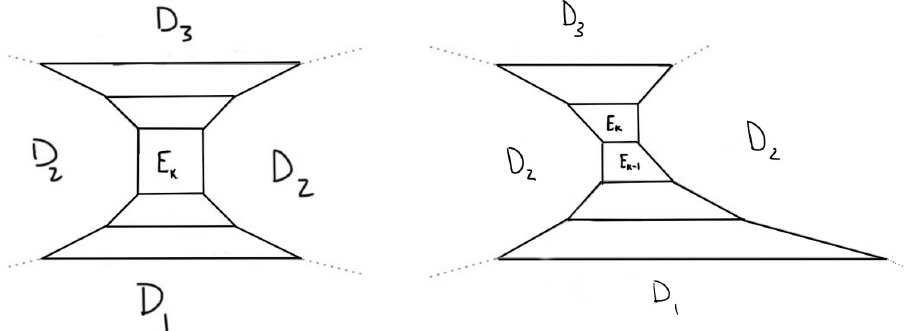
Figure 6. The figures depicted the general dual diagrams of the regular resolution of Z p -the quotient of the Hyperconifold. The figure on the left is the case of even p. On the right is the odd-p